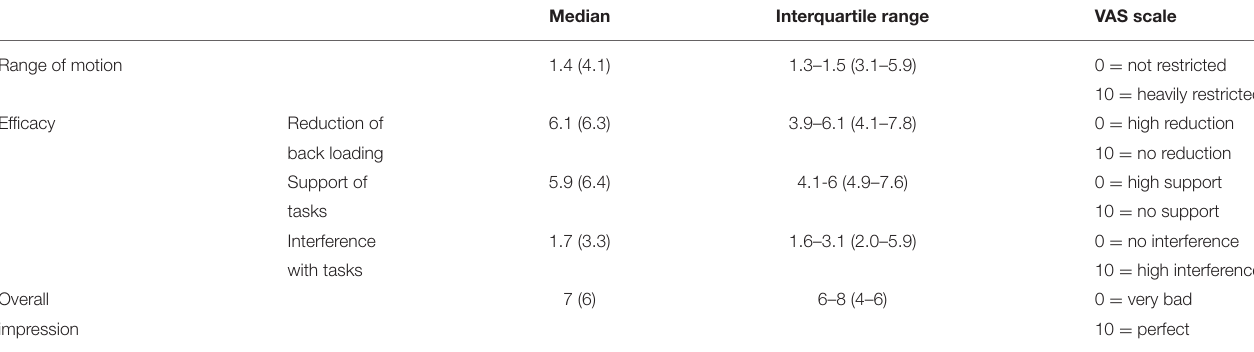
TABLE 2 | Users impression assessed by VAS scales: Numbers in brackets indicate the results of the study measured with Laevo in the study of Baltrusch et al. (2017).